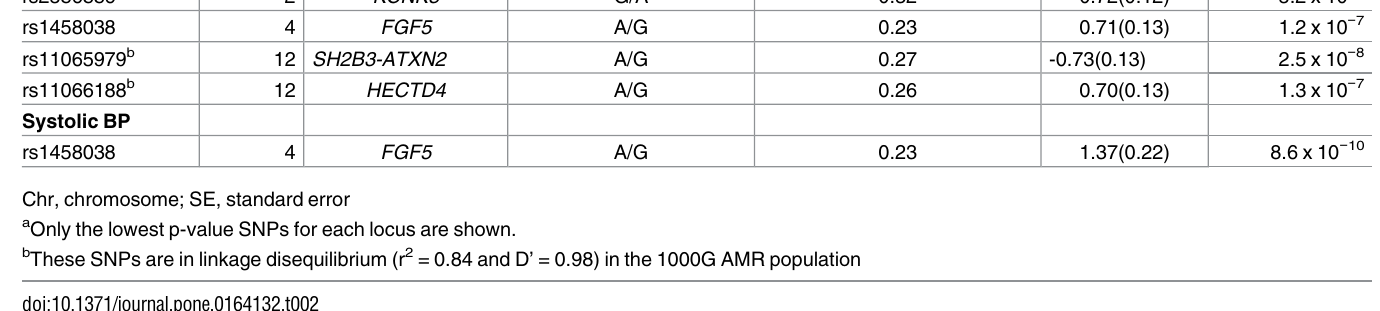
Table 2. Main findings a for meta-analysis of diastolic and systolic BP in PAGE Hispanic samples (n~19,706). SNP Chr Diastolic